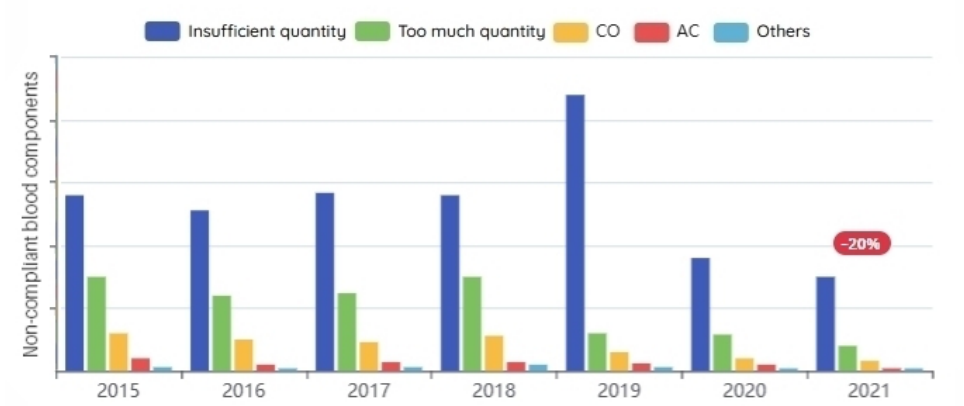
Figure 10. Non-compliant blood components before/after preparation per